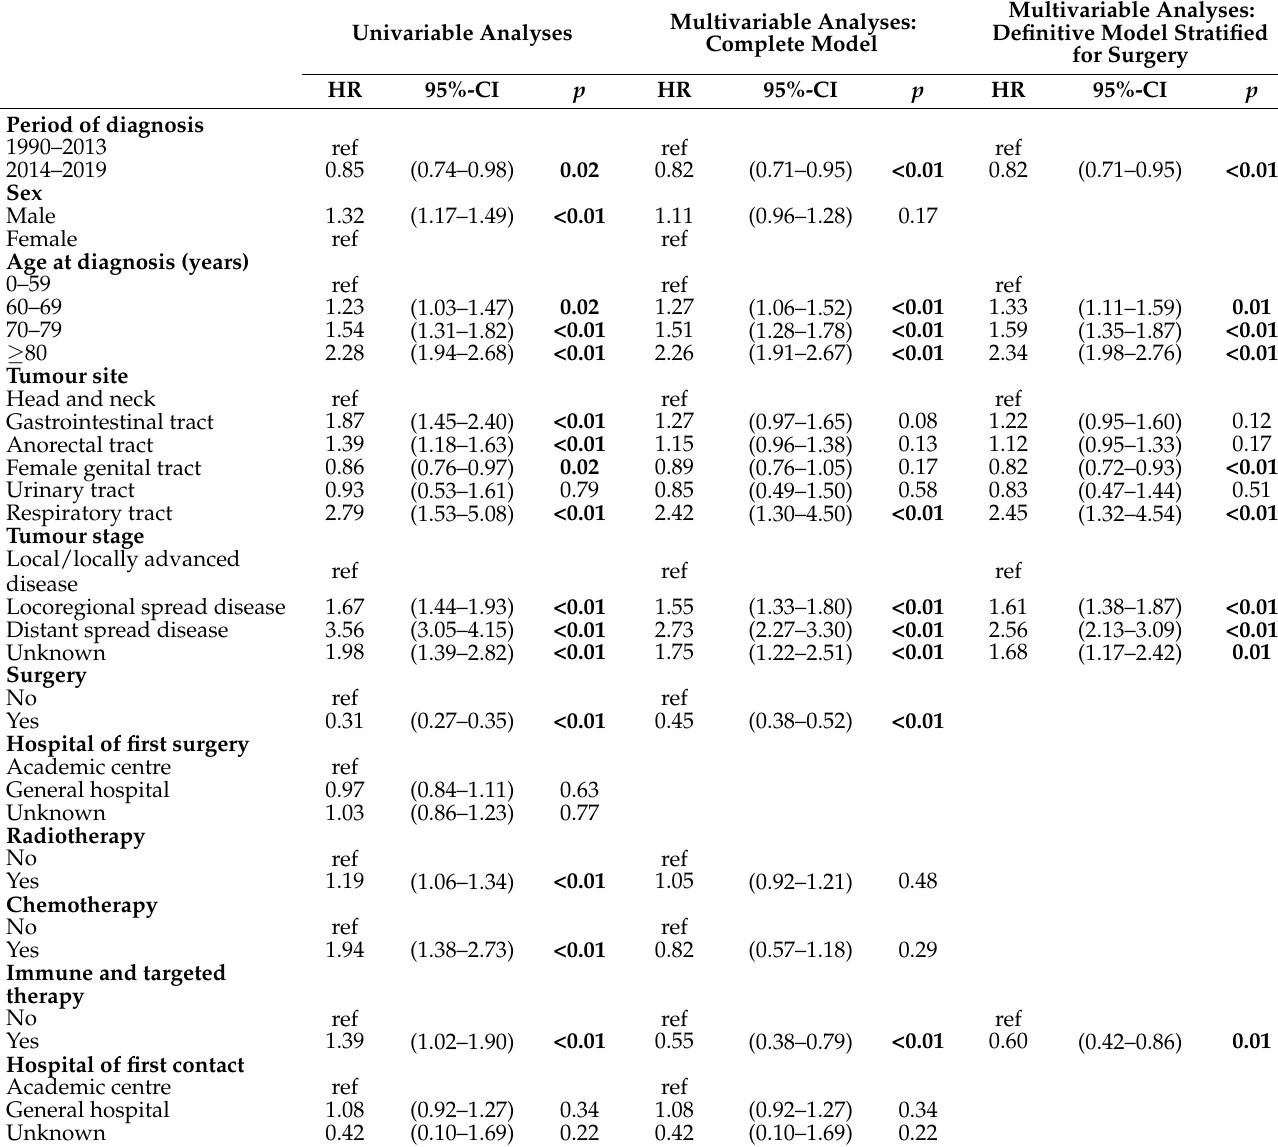
Table 4. Univariable and multivariable analysis on the impact of the period of diagnosis on the survival of patients with mucosal melanoma. Multivariable Analyses: Multivariable Analyses: Univariable Analyses Definitive Model Stratified Complete Model for